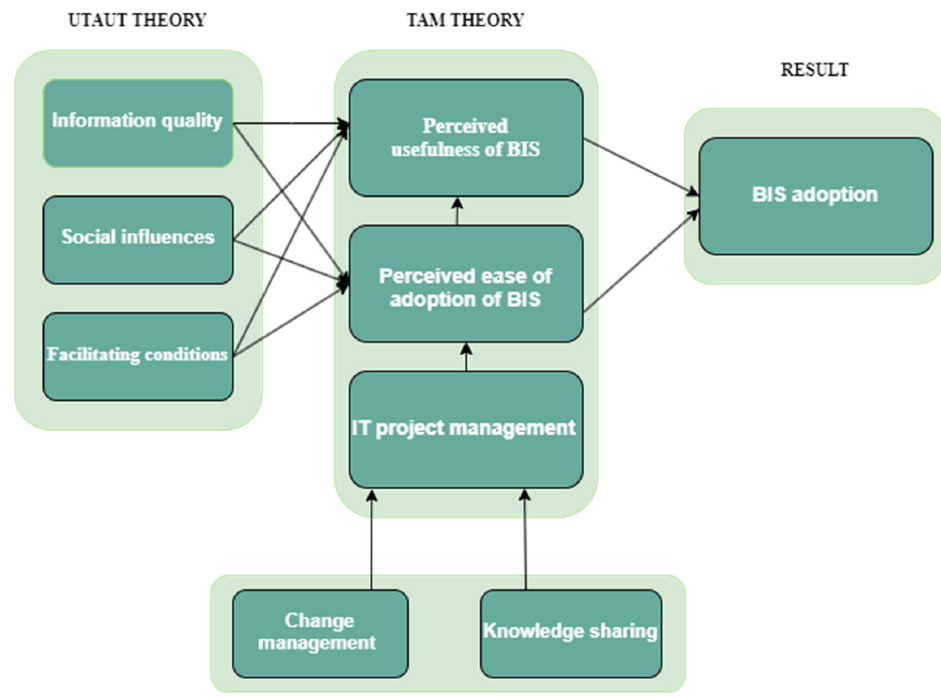
Figure 2. Proposed conceptual framework .